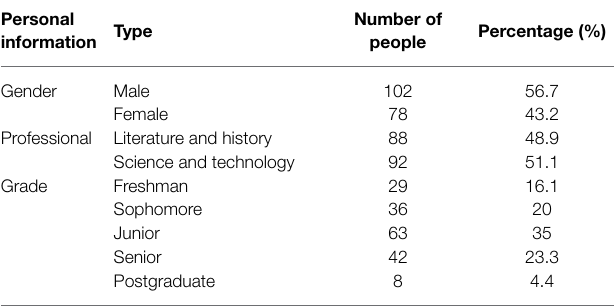
TABLE 1 | Composition of survey subjects.